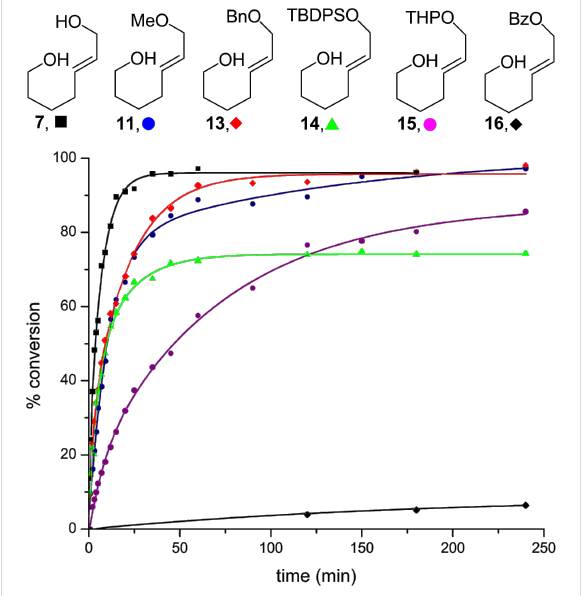
Figure 5: A comparison of commonly used protecting groups. Condi- tions: 5 mol % Au[P( t -Bu) 2 ( o -biphenyl)]SbF 6 , CH 2 Cl 2 , MS 4 Å.